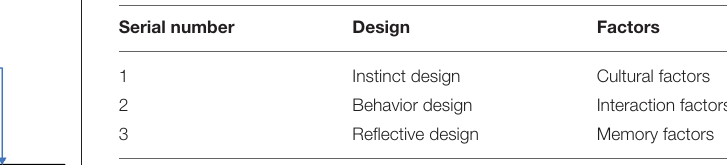
TABLE 4 | Emotional design three-level theory.